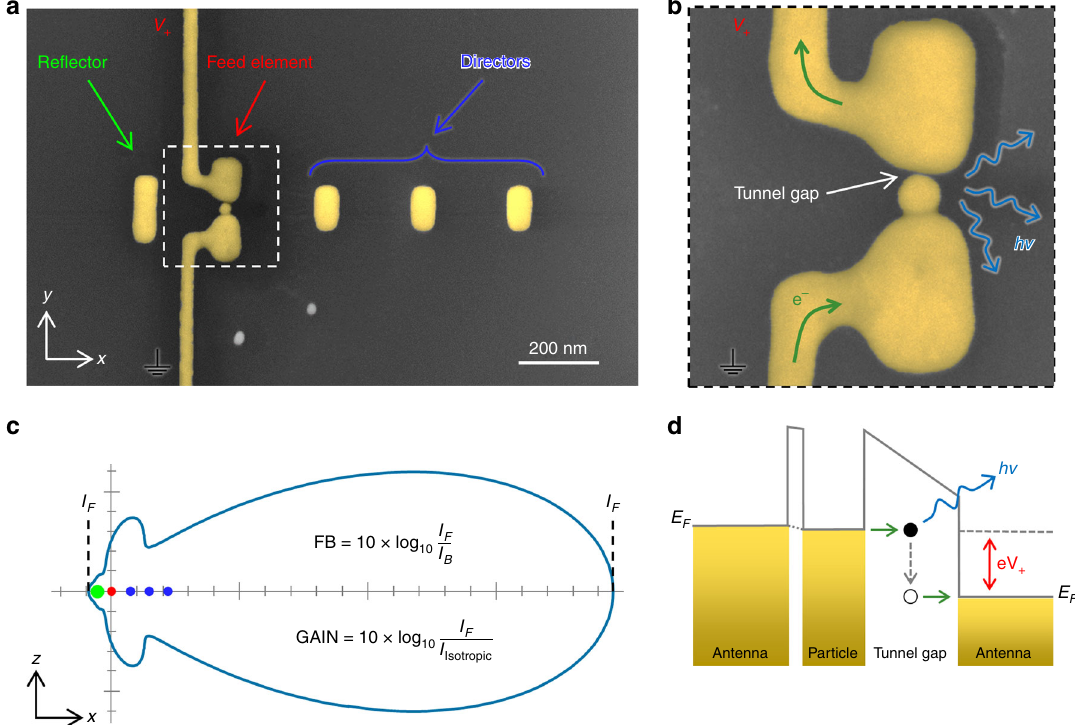
Fig. 1 Concepts of a Yagi-Uda antenna and inelastic electron tunneling. a SEM micrograph of a Yagi-Uda antenna containing re fl ector, feed element with kinked connectors and three directors on a glass substrate. b Zoom into the feed element highlighting the asymmetrically positioned particle creating a tunnel gap toward the top antenna arm. c Modeled emission characteristics of a Yagi-Uda antenna in the xz plane (for a homogeneous surrounding). The re fl ector and director elements lead to a highly unidirectional emission by generating constructive interference in the forward and destructive interference in the backward direction. The intensities in forward and backward direction can be used to de fi ne a forward-to-backward (FB) ratio and the antenna gain, see inset. d Schematics of the IET